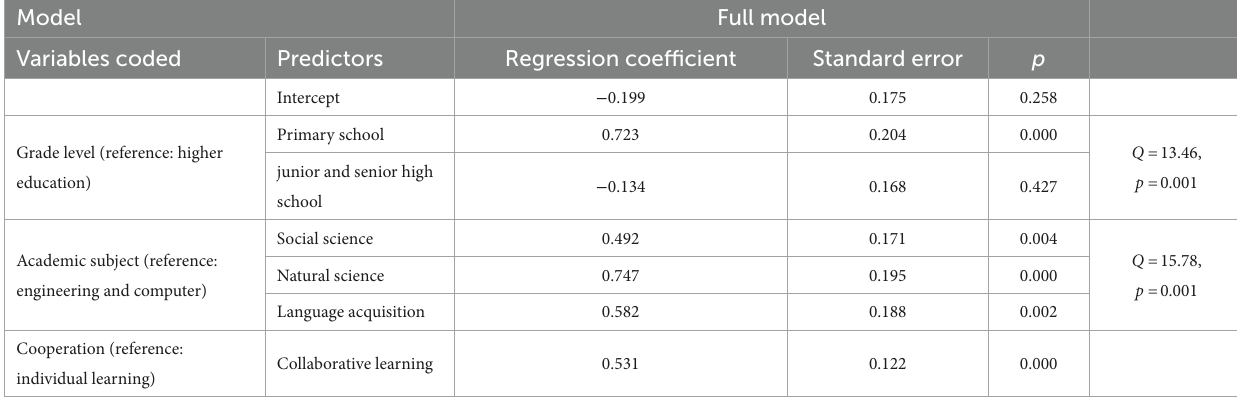
TABLE 10 Results of meta-regression of moderating variables.